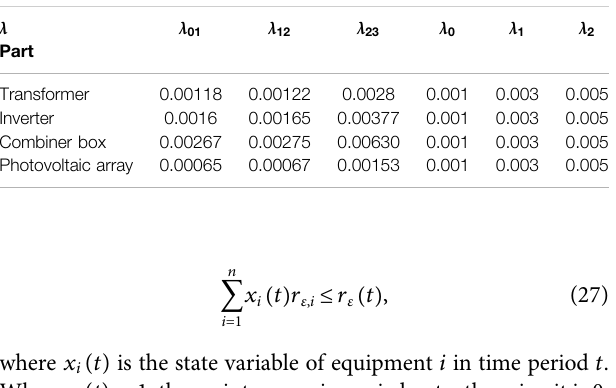
TABLE 2 | State transition rate of different devices. TABLE 3 | Maintenance costs of different maintenance methods.